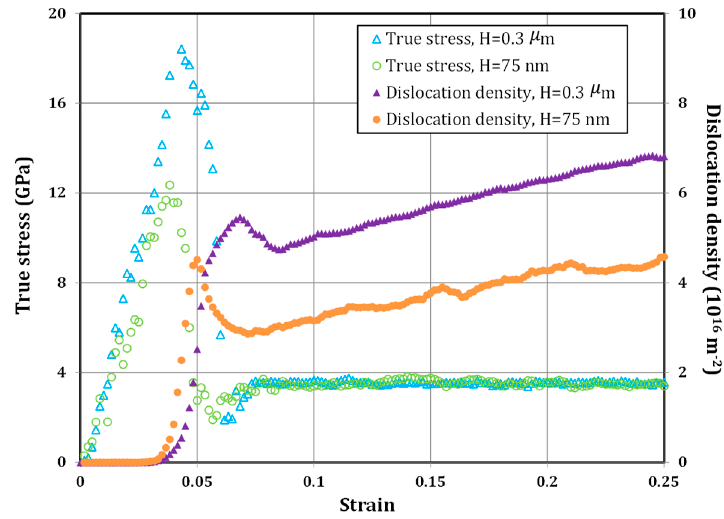
Figure 16. The comparison between the responses of the pillar with H = 75 nm and D = 135 nm versus the pillar with H = 0.3 µ m and D = 0.15 µ m during micropillar compression test (after Yaghoobi and Voyiadjis [21]).